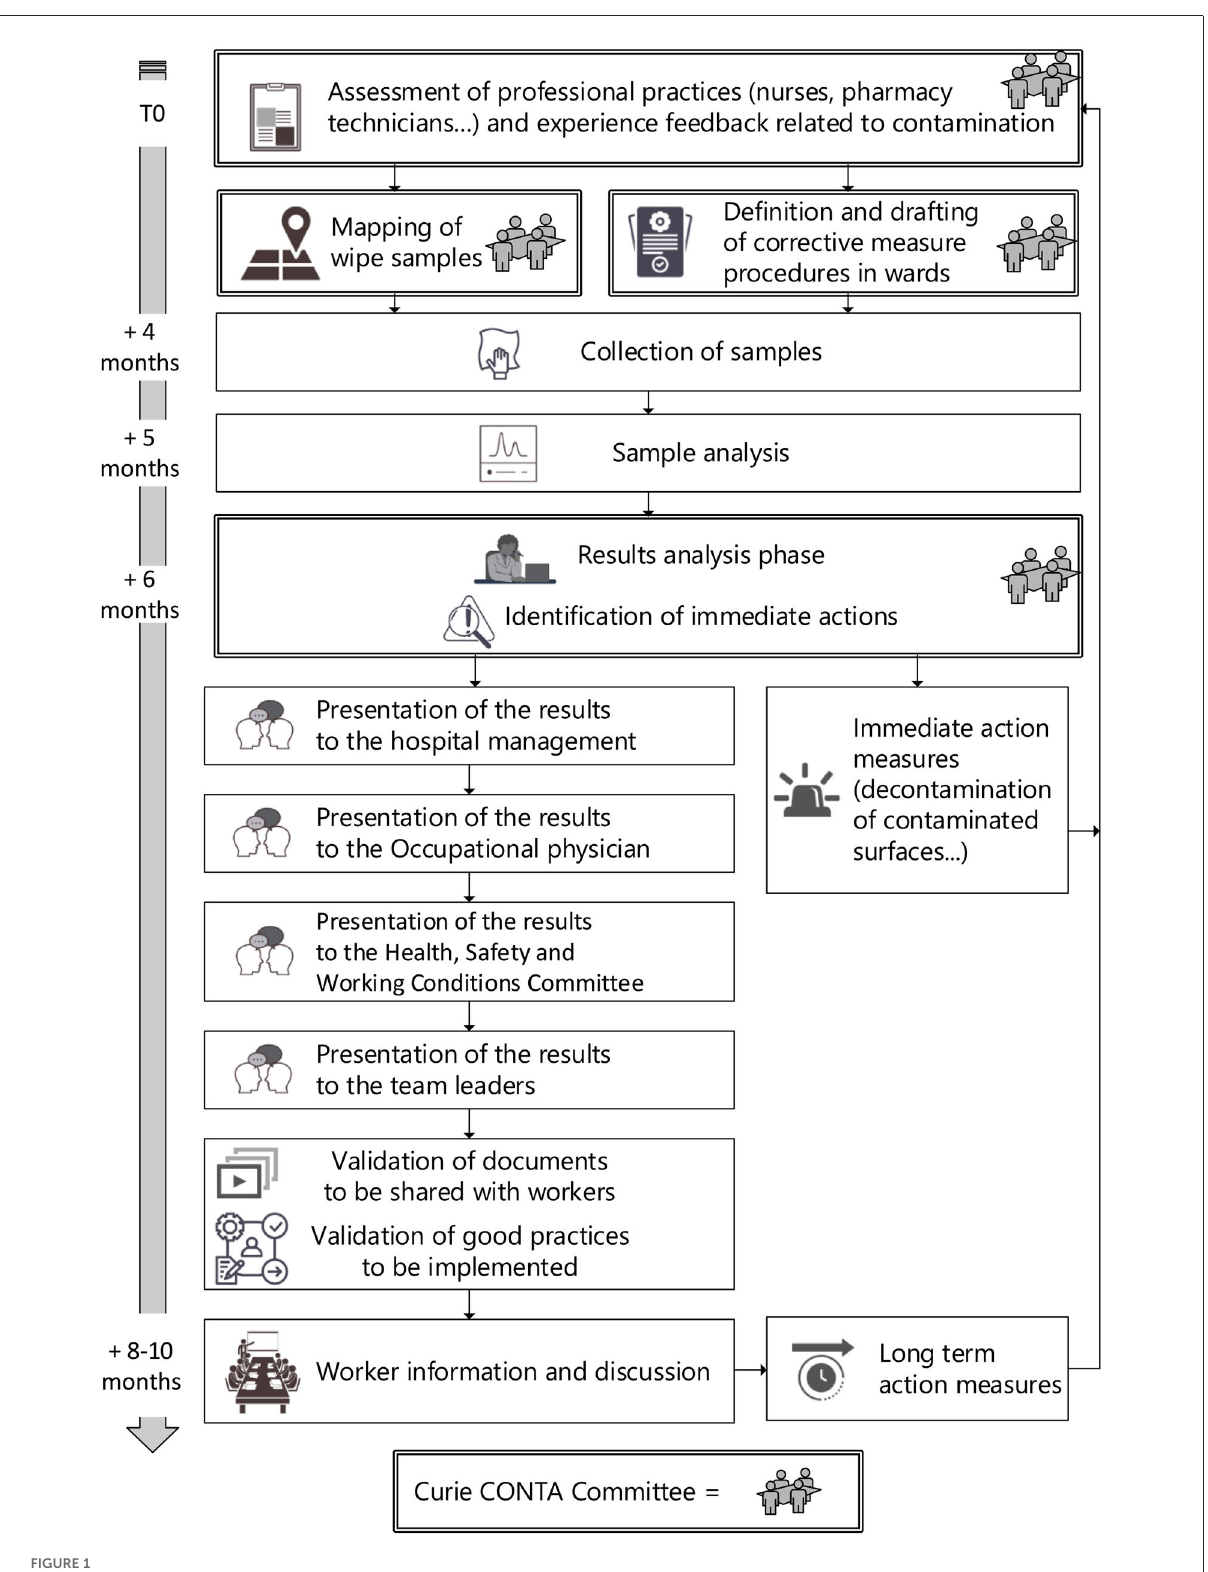
FIGURE1 Annual environmental monitoring procedure and communication strategy at Institut